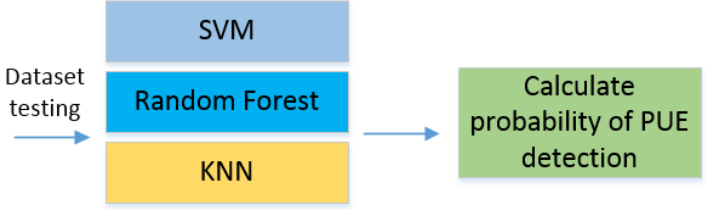
Figure 2. Machine learning techniques applied for PUE